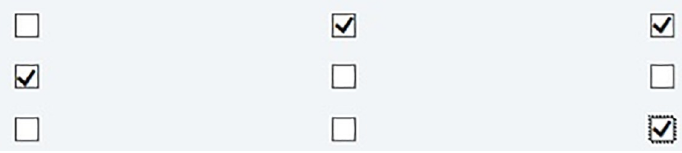
Fig 3. Example of a check marks pattern in the high-load